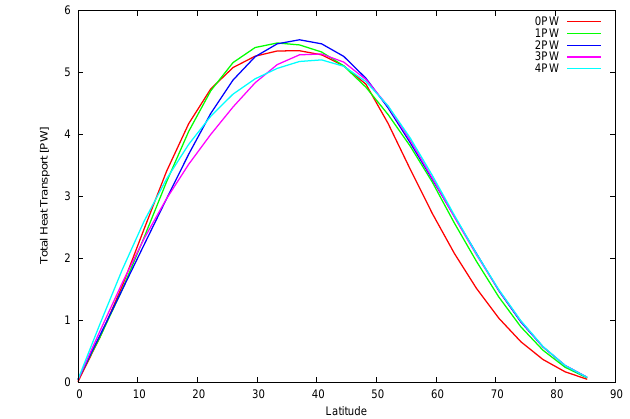
Figure 4. Total heat transport (in PW) diagnosed from energy bud- Figure 5. Time average of the global mean near-surface tempera-